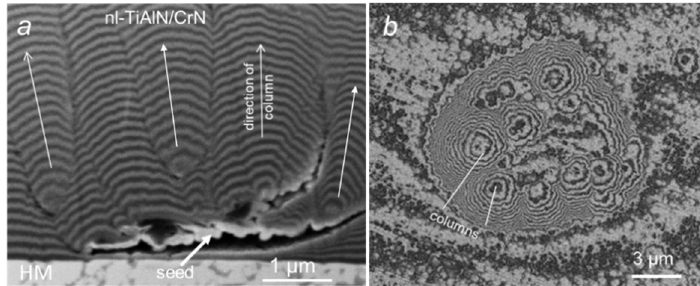
Figure 12. FIB image of a nodular defect in the nl-TiAlN / CrN nanolayer coating; several columns are formed on the surface of the seed with complex geometry (see arrows) ( a ) and SEM top view image of the ground section of the nodular defect caused by a seed with complex geometry ( b ).